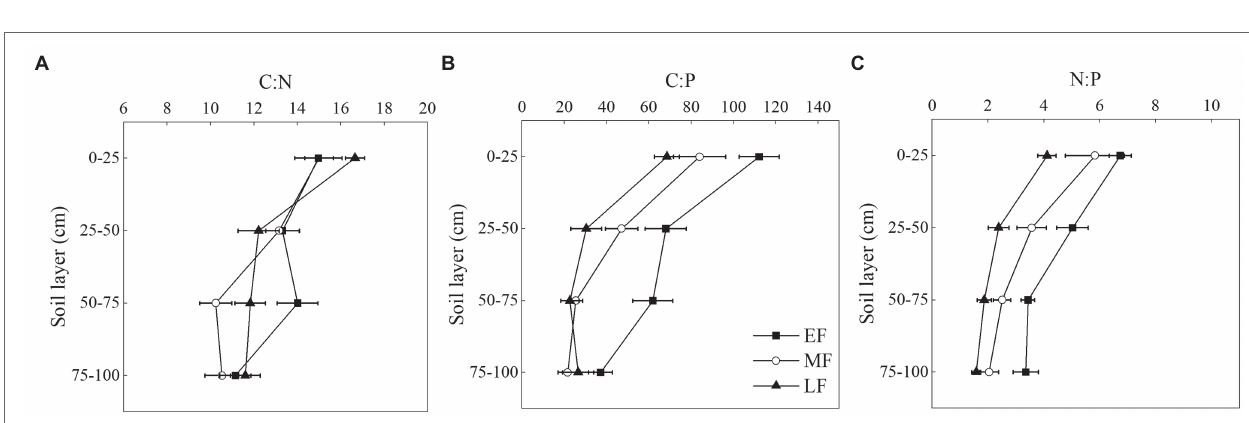
FIGURE 4 | Vertical changes of C:N (A) , C:P (B) , and N:P (C) in the 0–100 cm soil layer of different forests. Values are the means ± SE ( n = 6). C:N, SOC:TN; C:P, SOC:TP; N:P, TN:TP; EF, broadleaf–conifer mixed forest; MF, broad-leaved forest; LF, old-growth